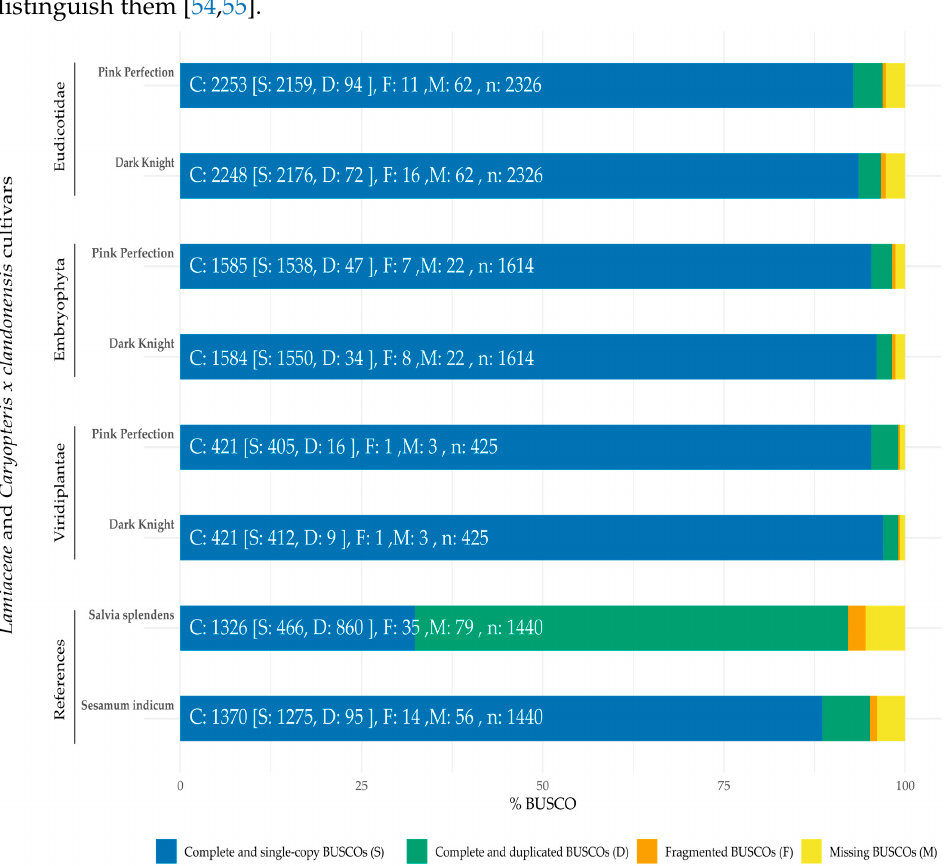
Figure 2. Comparison of BUSCO completeness of different cultivars of Caryopteris x clandonensis as well as Salvia splendens [37] and Sesamum indicum [38]. As the genomes were compared to other Benchmarking Universal Single-Copy Orthologs (BUSCO) datasets a normalization was performed to enable a comparison in genome completeness. Pink Perfection and Dark Knight were compared to the BUSCO datasets of Viridiplantae , Embryophyta and Eudicotidae , whereas S. splendens and S. indicum were compared to Viridiplantae only. Reference genomes were obtained from